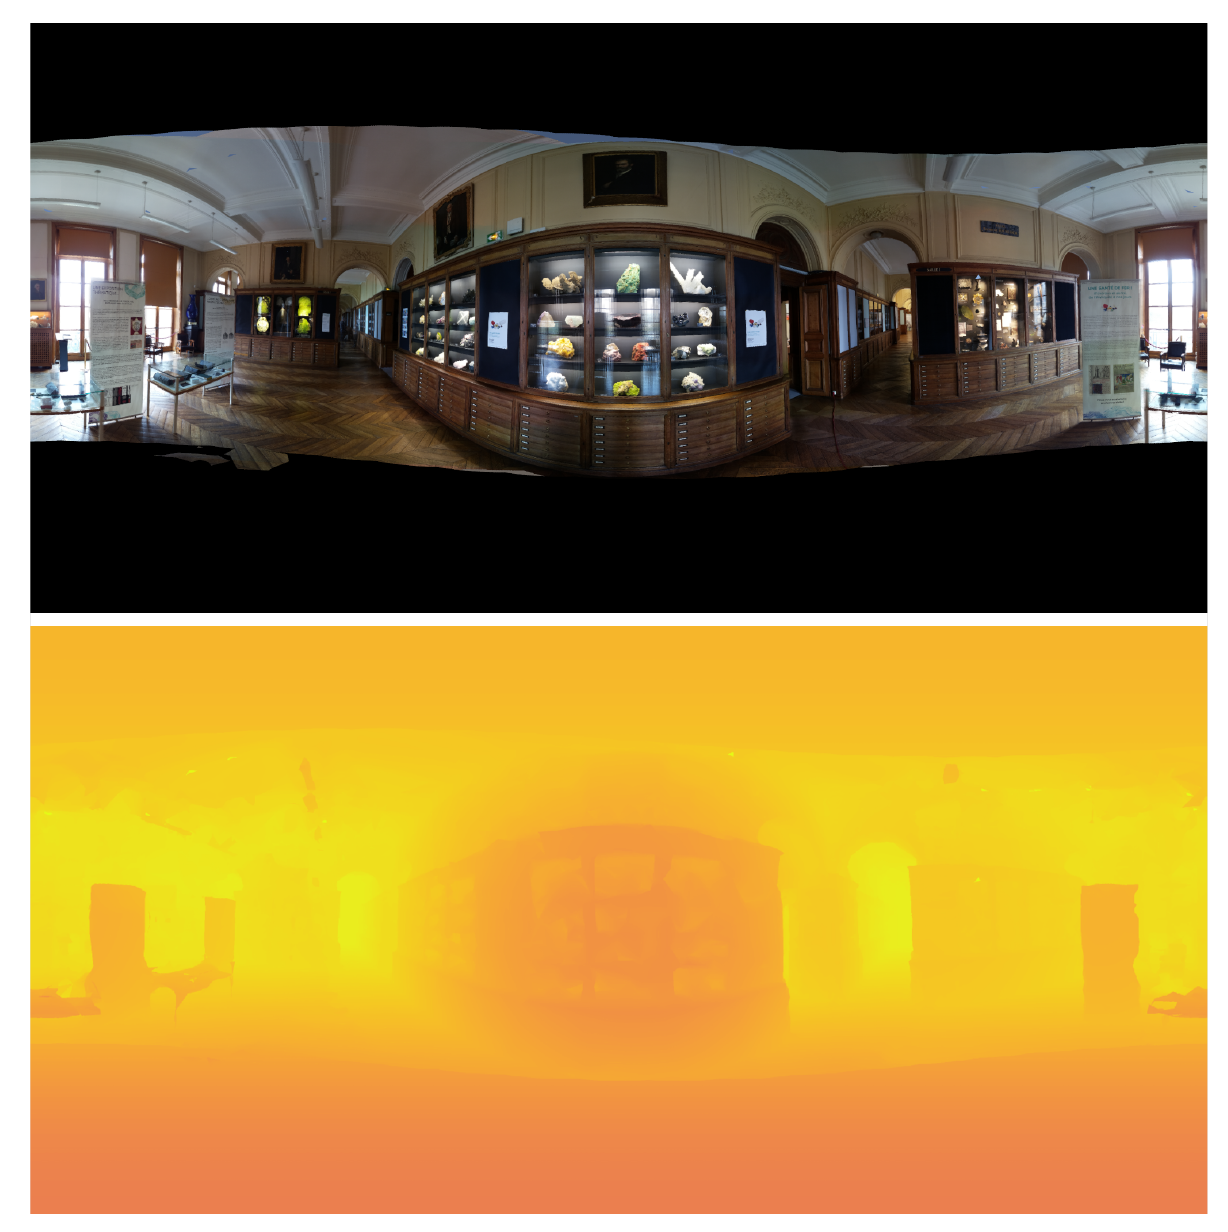
Figure 5. The images show 360° color and depth panoramas obtained by placing a virtual camera in the center of the “Museum” scene. Note that we generated these panoramas from the scene simply for illustration: no 360° photographs were captured or rendered during the